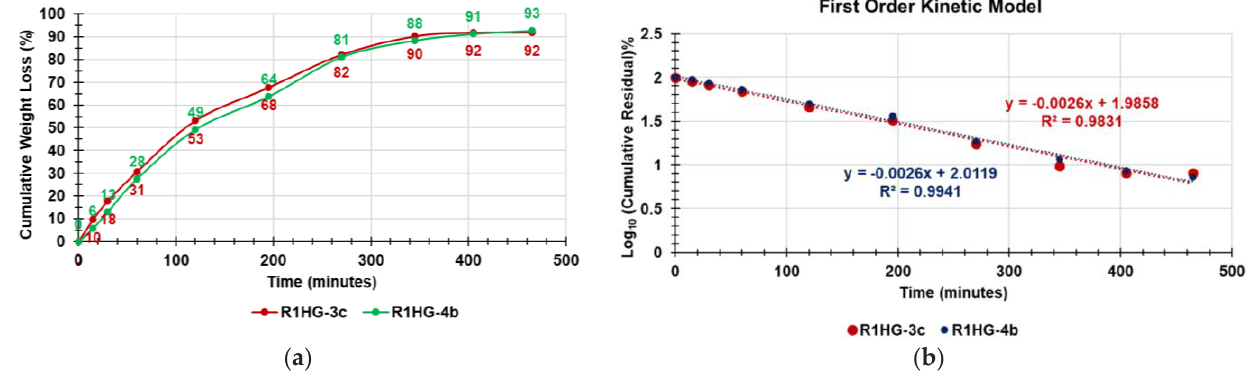
Figure 12. Cumulative weight loss percentage curves of R1HG-3c (red line) and R1HG-4b (green line) over time and gentle heating ( a ); first-order kinetic models fitting data of the cumulative weight loss curves of R1HG-3c and R1HG-4b ( b ).